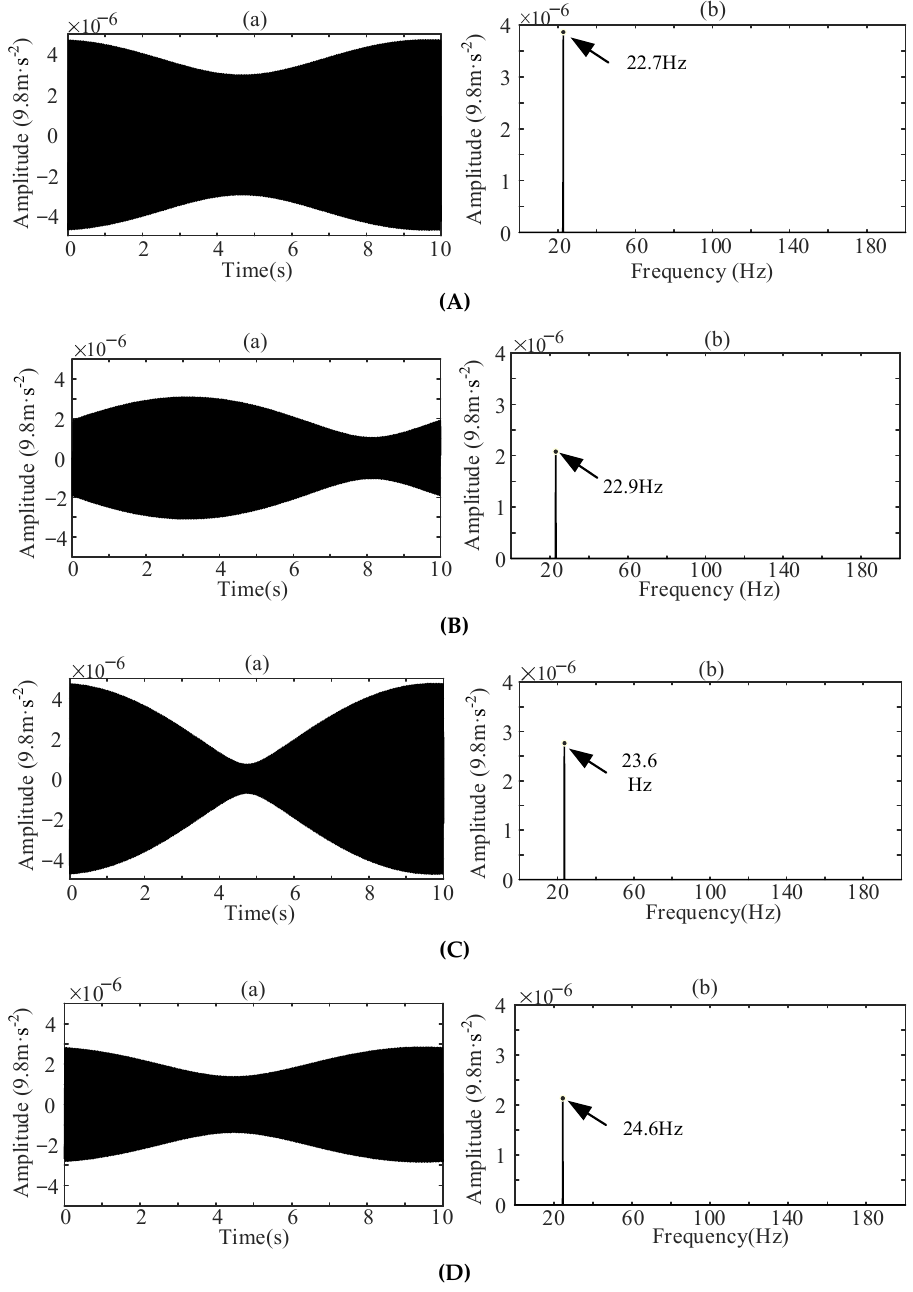
Figure 10. Time domain waveform and frequency spectrum of extracted frequency: ( A ) 22.7 Hz; ( B ) 22.9 Hz; ( C ) 23.6 Hz; ( D ) 24.6 Hz.